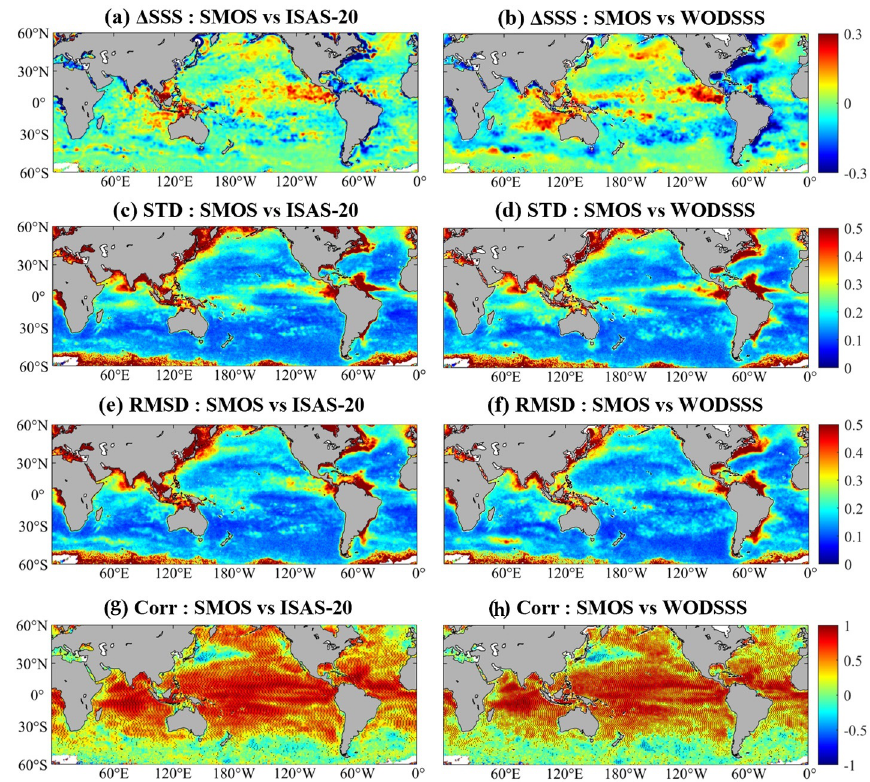
Figure 8. Comparison of Soil Moisture and Ocean Salinity (SMOS) SSS with (left) ISAS-20 and (right) WODSSS in terms of ( a,b ) ∆ SSS, ( c,d ) STD, ( e,f ) RMSD and ( g,h ) correlation coefficient. Areas are specifically shaded where the correlation coefficients pass the 95% significance test with the corresponding p-values smaller than 0.05. The differences in time-mean SSS do not contribute to the STD values just as they do to the RMSD values.